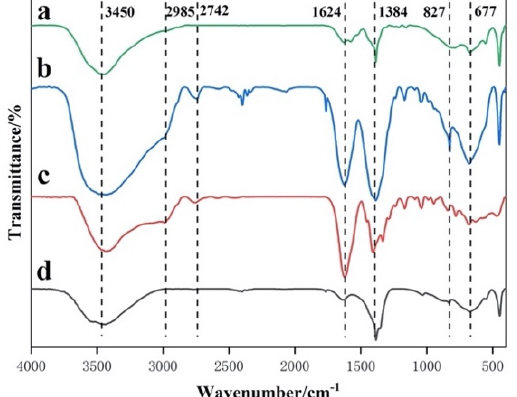
Figure 6. FTIR patterns of re-Mg 3 Al–Pro-LDHs (a), Mg 3 Al–Pro-LDHs (b), L-proline (c), and Mg 3 Al– LDHs (d).